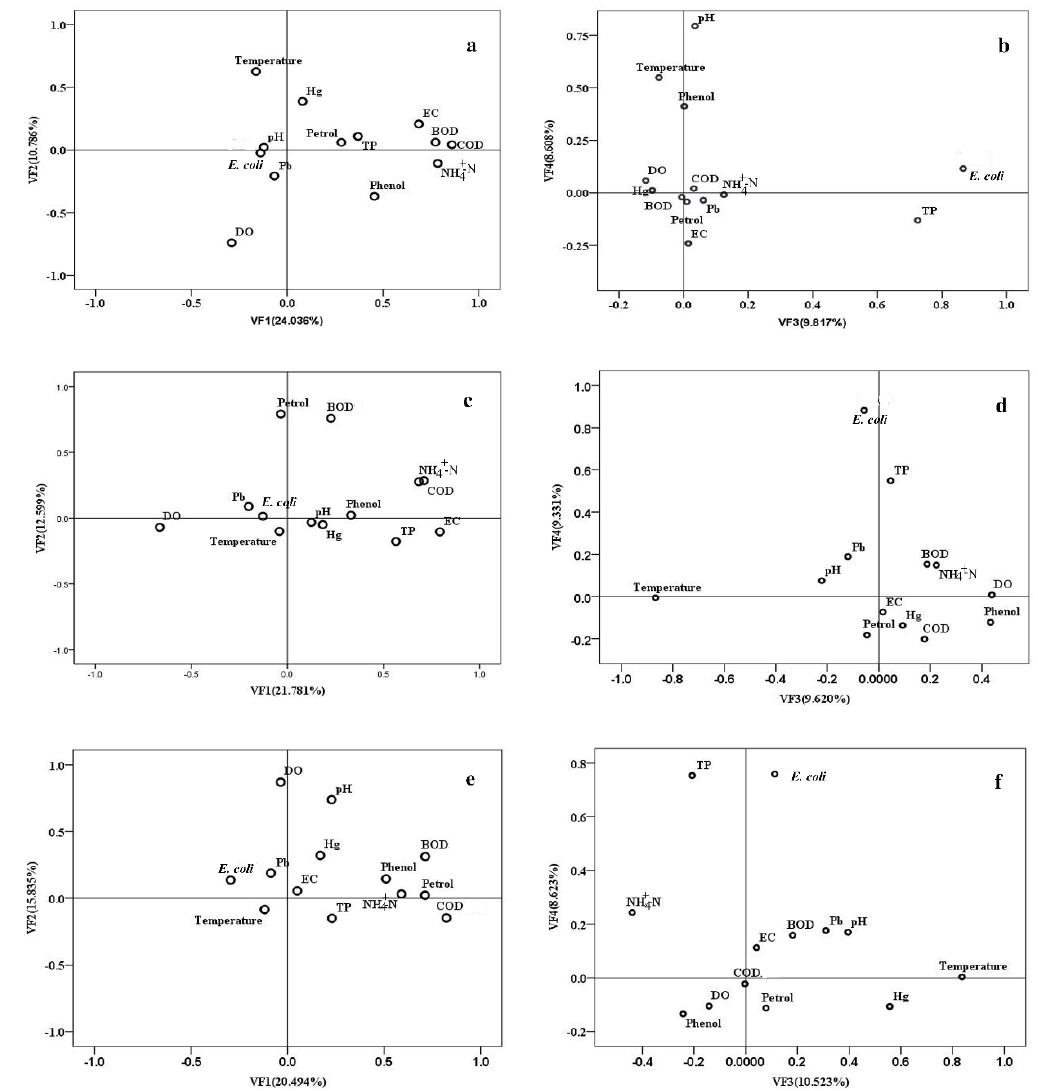
Figure 7. Scatter plot of loadings for the four VFs for group A ( a , b ); group B ( c , d ) and group C ( e , f ).